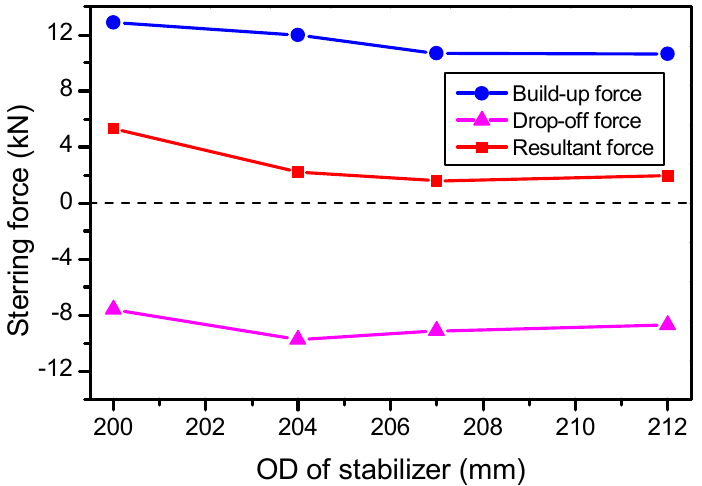
Figure 18. Steering force versus stabilizer diameter.